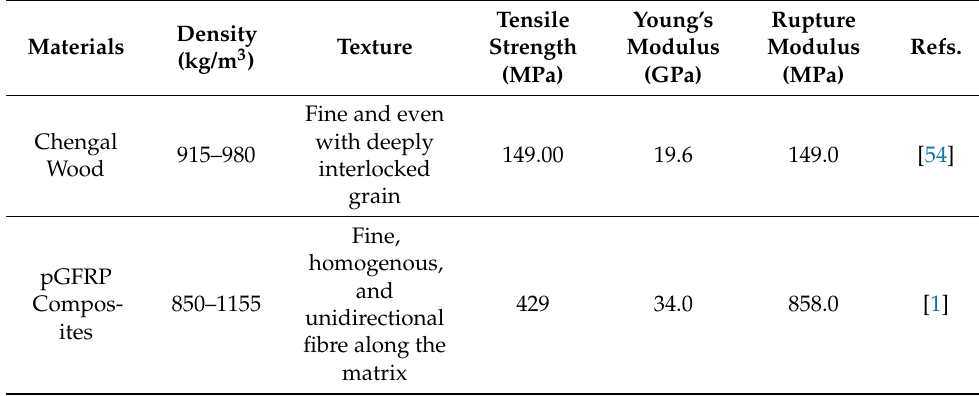
Table 4. Comparison of characteristics of Chengal wood and pGFRP composites as non-conductive materials of cross